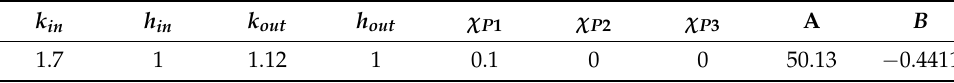
Table 4. The adopted material-dependent coefficients.